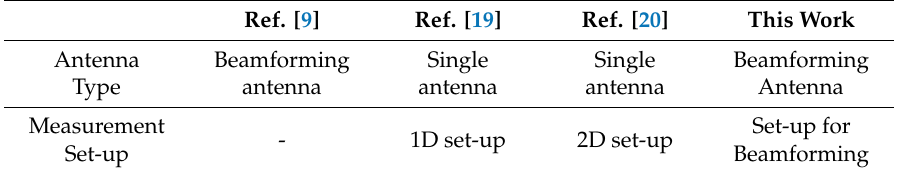
Table 4. Comparisons of the proposed 4 × 4 beamforming antenna and reference antennas. Ref.